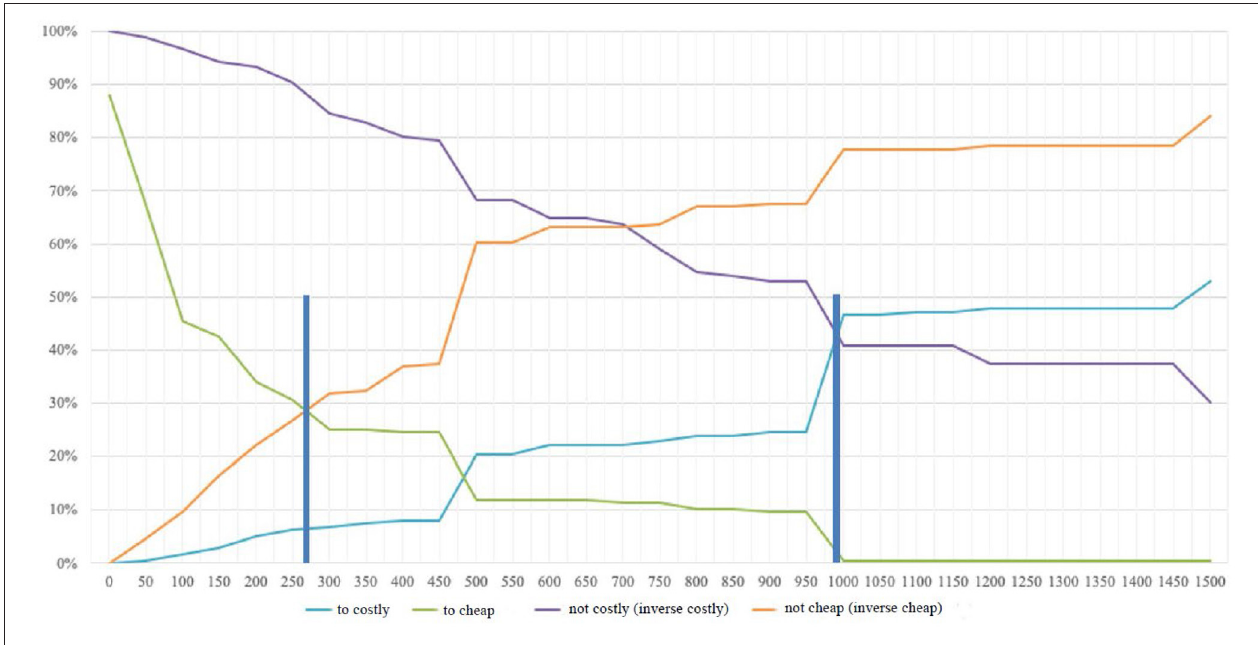
FIGURE 2 | Determination of the acceptable price range according to Van Westendorp (1976).